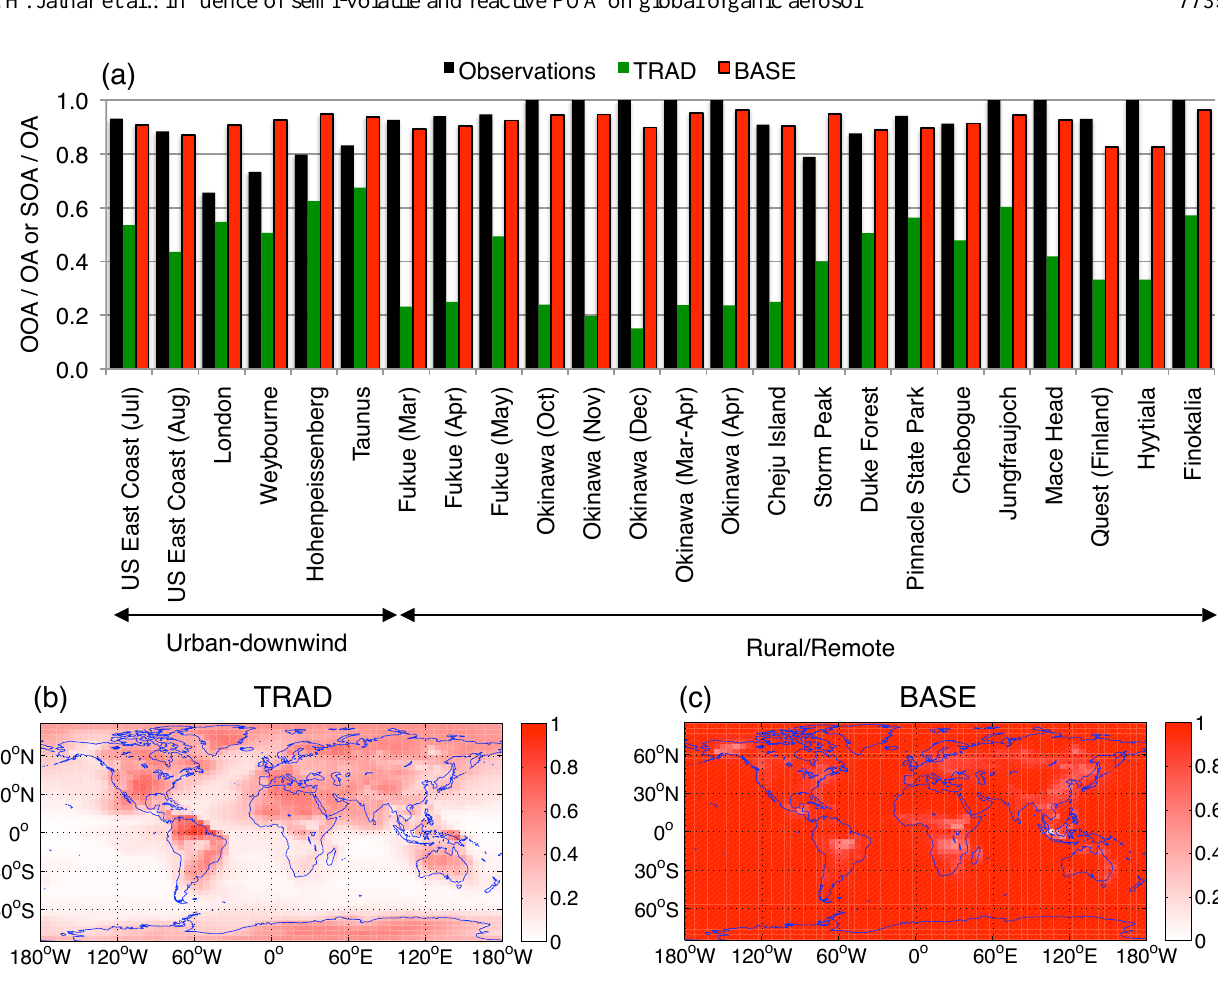
Fig. 5. (a) Comparison of observed OOA to OA ratios with model results of SOA to OA ratios from the BASE and TRAD scenarios. Model-predicted global distribution of SOA to OA ratio for (b) TRAD and (c) BASE cases. Data in (a) are from Zhang et al.